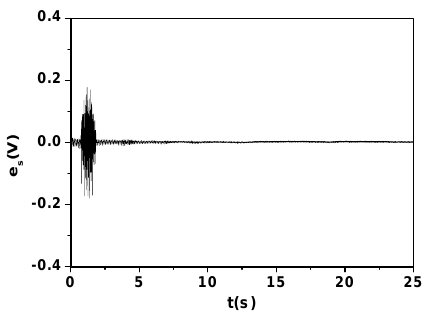
Fig. 6. Error evolution – SM − BNDRLMS algorithm applied to case C 1